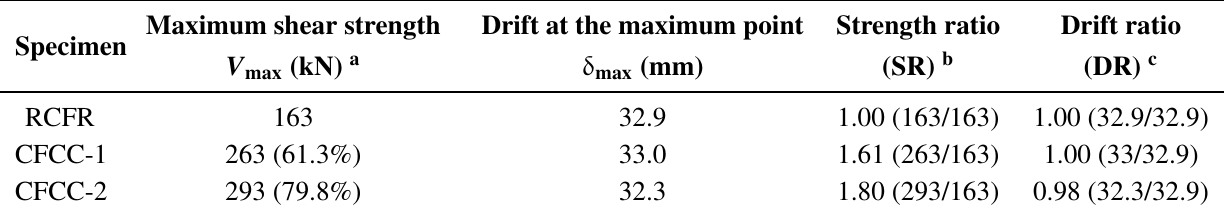
Figure 12. The envelope of the load–drift relations of the three specimens. Table 7. Summary of the strengths and deformation capacities.